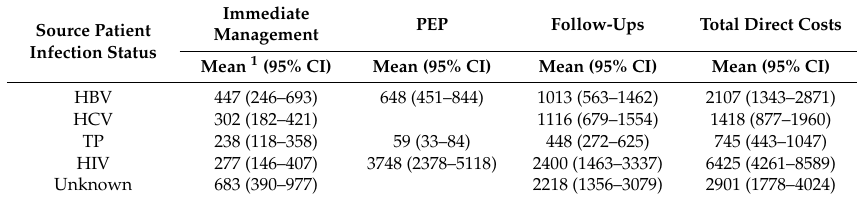
Table 3. Direct costs of the BBF exposure management in Beijing, China (in Chinese RMB).